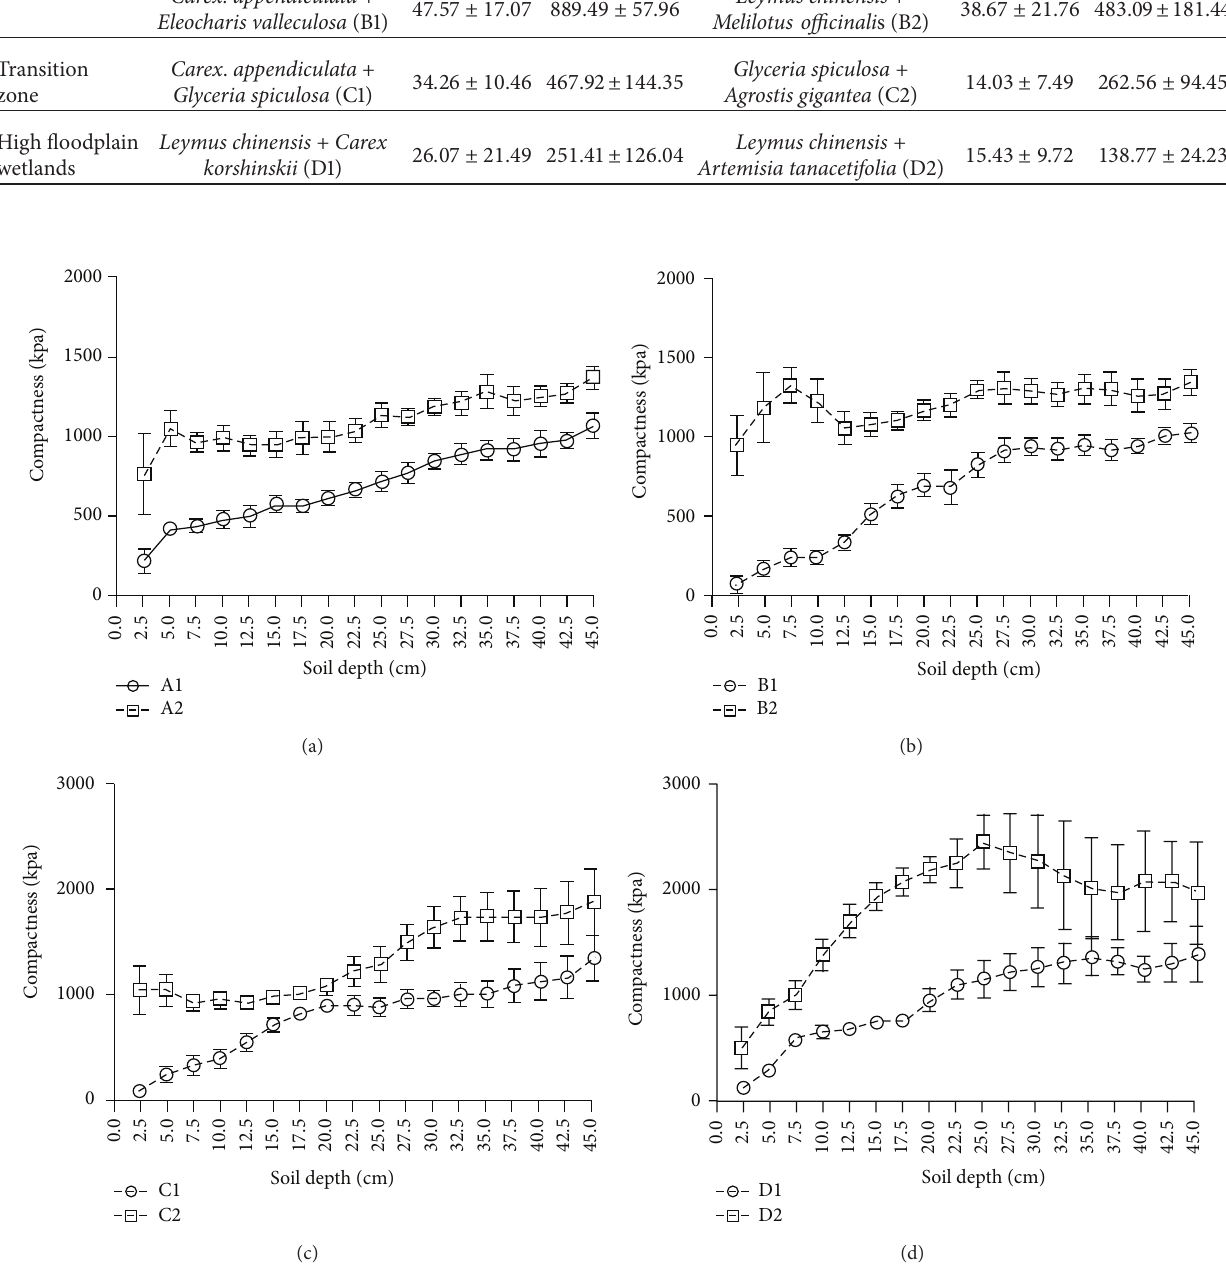
Figure 3: Spatial distribution of soil